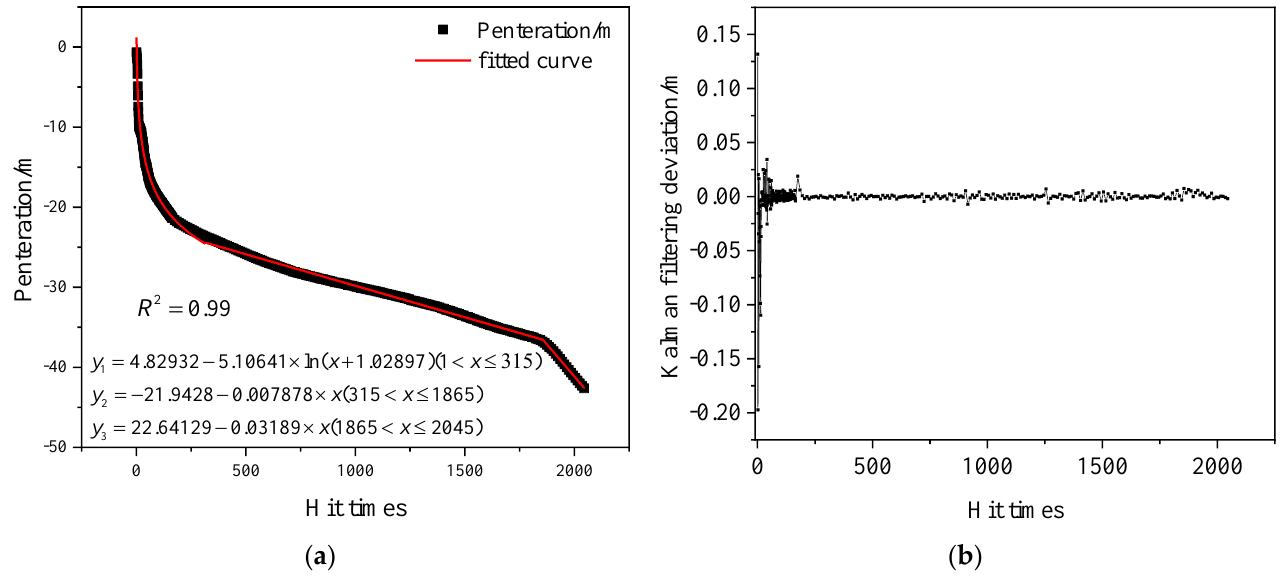
Figure 12. Diagram of penetration change in large diameter pipe pile at pile position 6, showing the ( a ) fitting analysis of penetration evolution law at pile position 6, and ( b ) sketch of the penetration Kalman filter deviation.